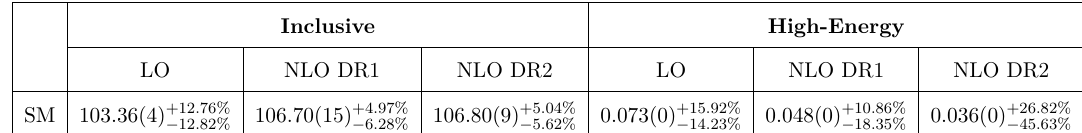
Table 2 . The SM contributions [fb] to the inclusive and the high-energy tWZ production at LO √ and NLO, including QCD scale uncertainties, for the LHC s = 13 TeV. These results are for DR1 and DR2 predictions when applying a veto on b -quarks with | η | < 2 . 5 or p T > 30 GeV. The stability of the SM DR1 and DR2 cross sections signifies the efficiency of the b -veto.